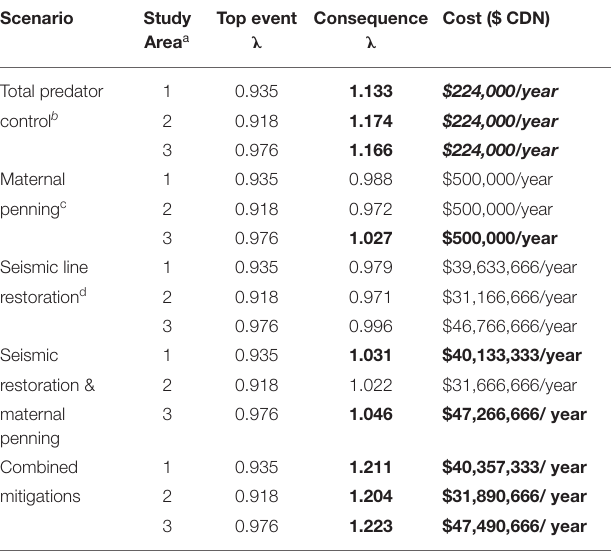
TABLE 2 | Risk quantification and costing for five different mitigation scenarios in three study areas having Woodland boreal caribou in Northeastern British Columbia, Canada, under the presented BRAT